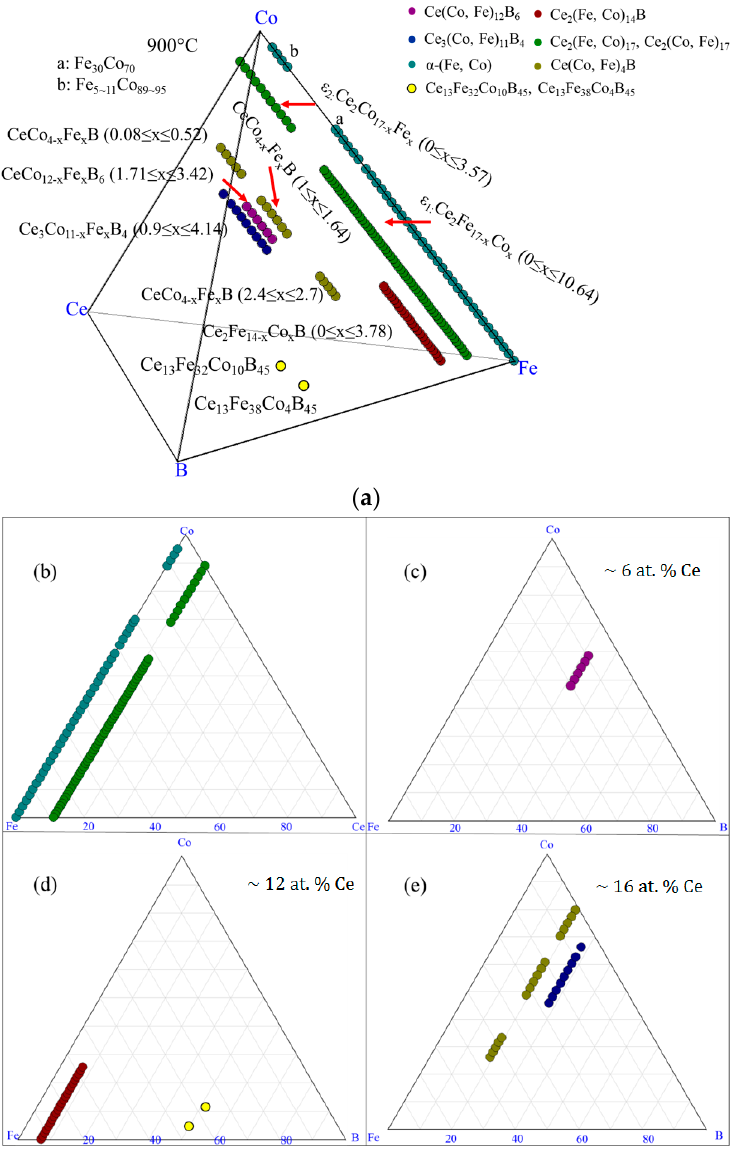
Figure 9. The diffusion couples results of the Ce-Fe-Co-B system at 900 °C: ( a ) 3D presentation of the experimental results; ( b ) Fe-Ce-Co ternary system; ( c ) pseudo ternary section at ~6 at. % Ce; ( d ) pseudo ternary section at ~12 at. % Ce; ( e ) pseudo ternary section at ~16 at. % Ce.